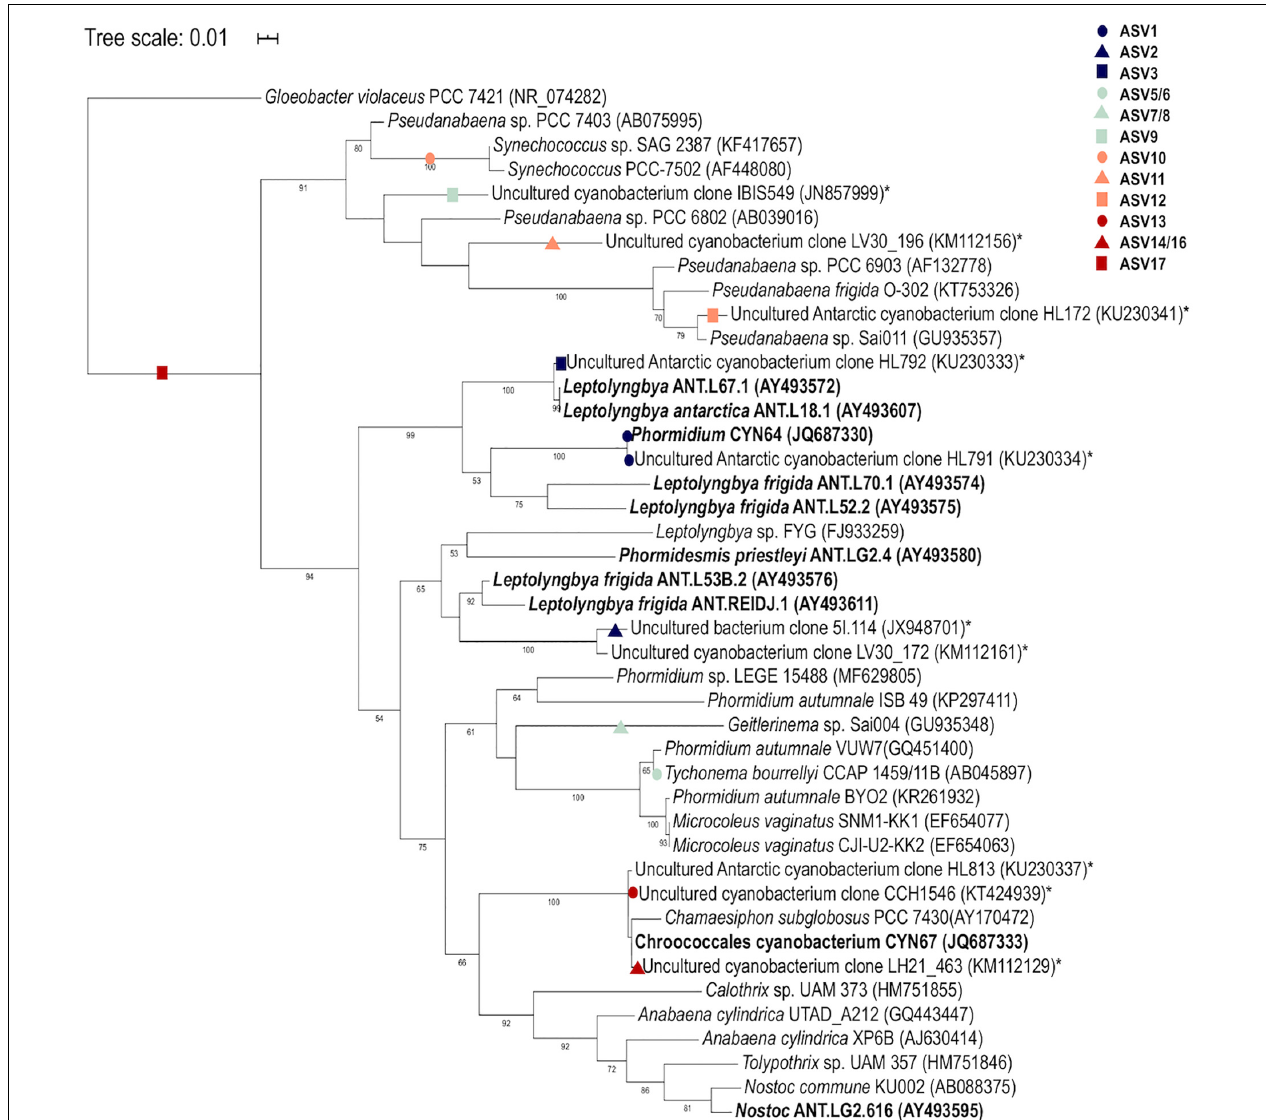
FIGURE 5 | Phylogenetic mapping analysis of Lake Untersee cyanobacterial ASVs. Mapping of sequences from this study are denoted by colored shapes. Environmental sequences from Antarctic environments are denoted by asterisk (*) and Antarctic strains are denoted in bold. Bootstrap values > 50% are labeled.